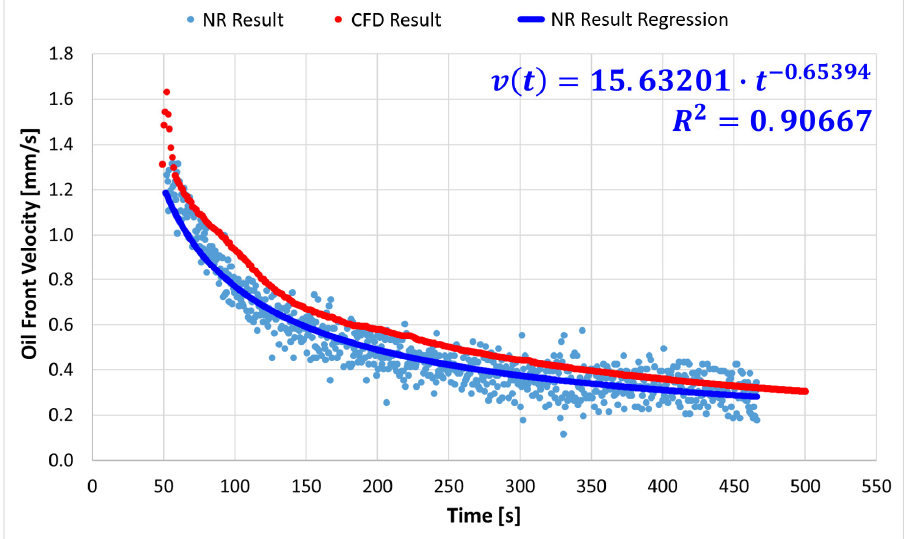
Figure 18. Oil front velocity comparison for “Top” case.